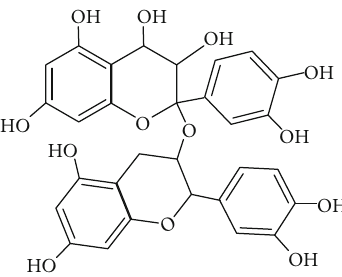
Figure 1: The chemical structure of